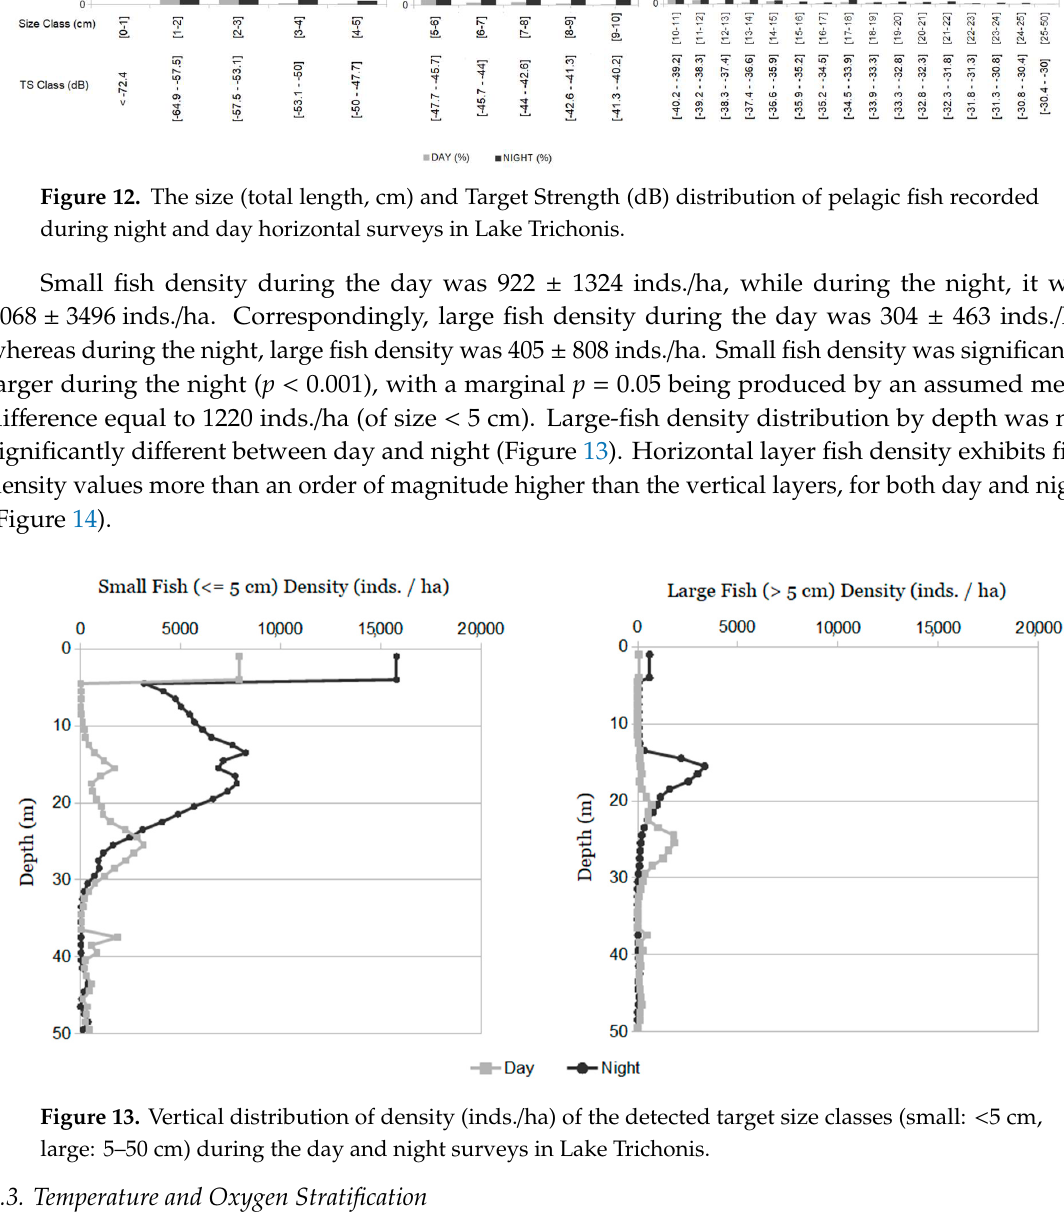
Figure 12. The size (total length, cm) and Target Strength (dB) distribution of pelagic fish recorded during night and day horizontal surveys in Lake Trichonis.